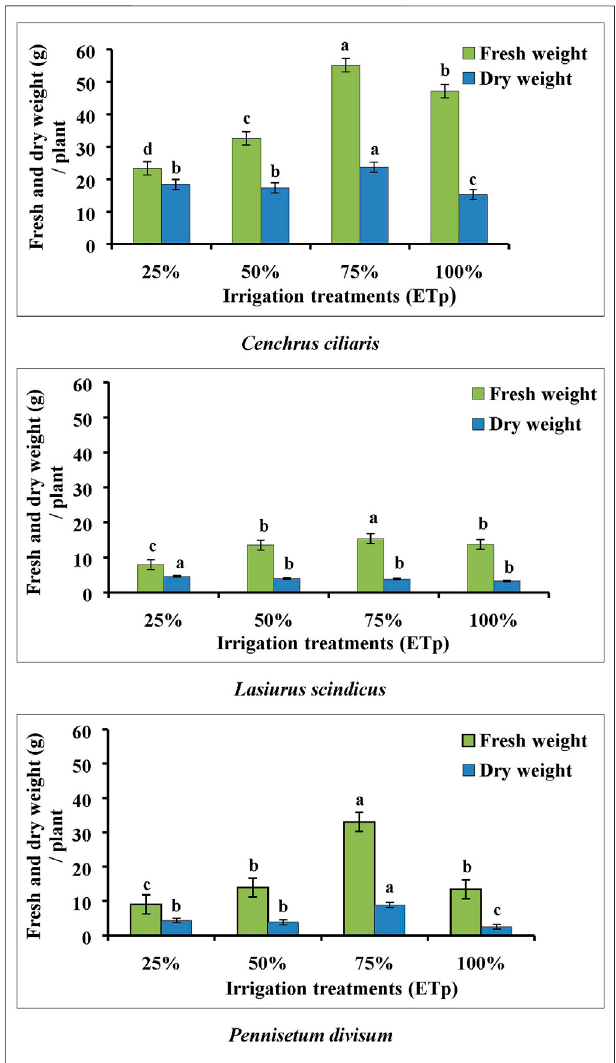
FIGURE 4 | Effect of different irrigation regimes on mean fresh and dry weightmeasurementof Cenchrusciliaris , Lasiurusscindicus ,and Pennisetum divisum . Bars labeled with different letters present signi fi cant difference between treatments at p < 0.001 and p < 0.05. d. f = 16.